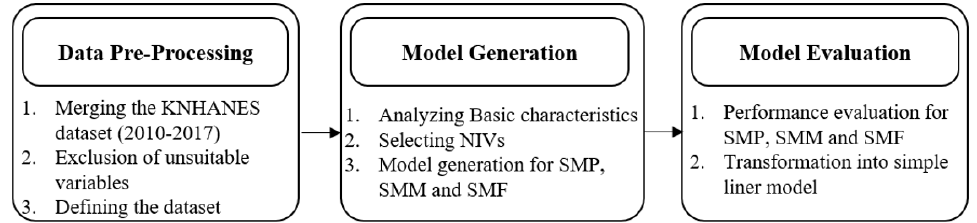
Figure 1. Research framework for the development of a family history of diabetes (FHD) screening model.